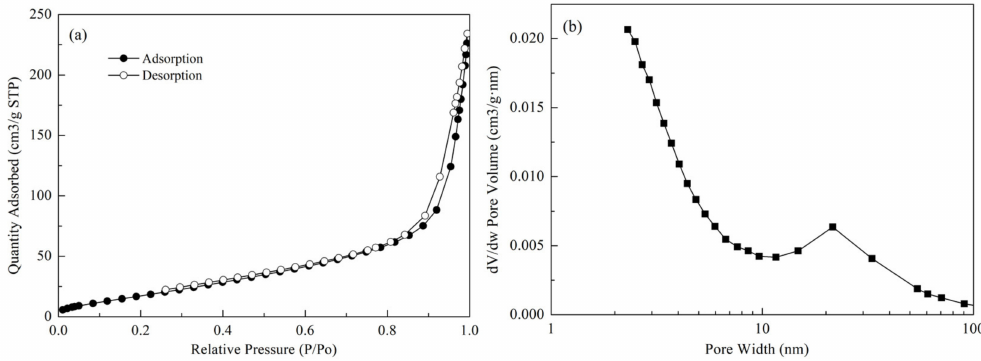
Figure 9. Adsorption desorption curve ( a ) and pore size distribution ( b ) of roasted